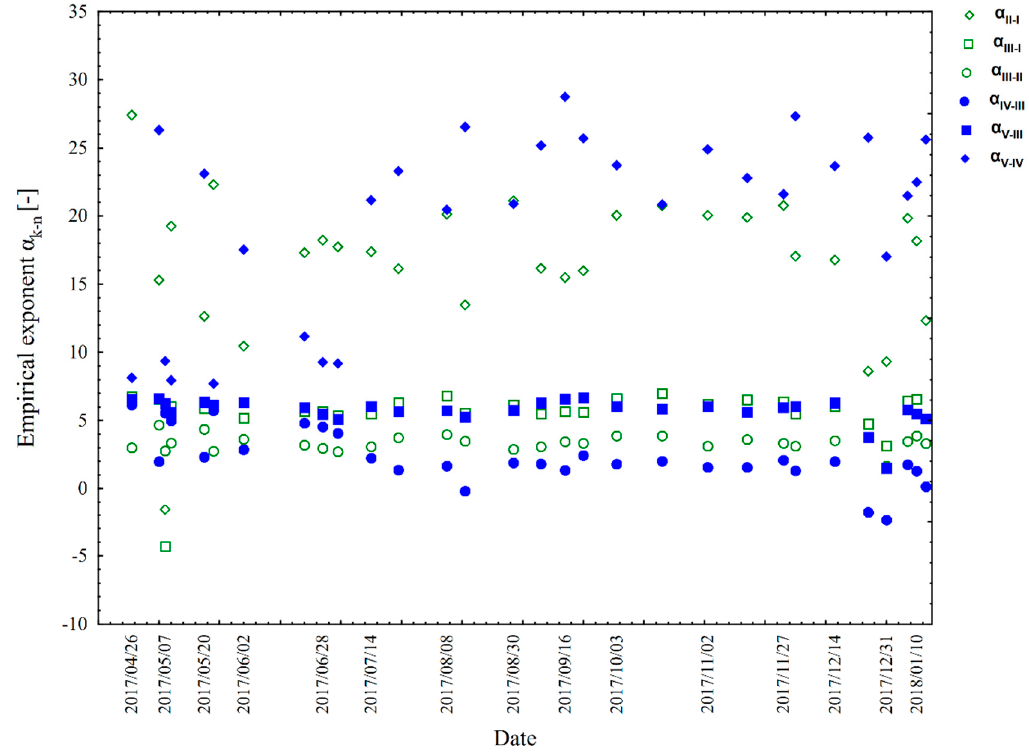
Figure 3. Diagram of dispersion of exponents α k − n for the pressure reduction (green markers) and pressure increase (blue markers) phases.